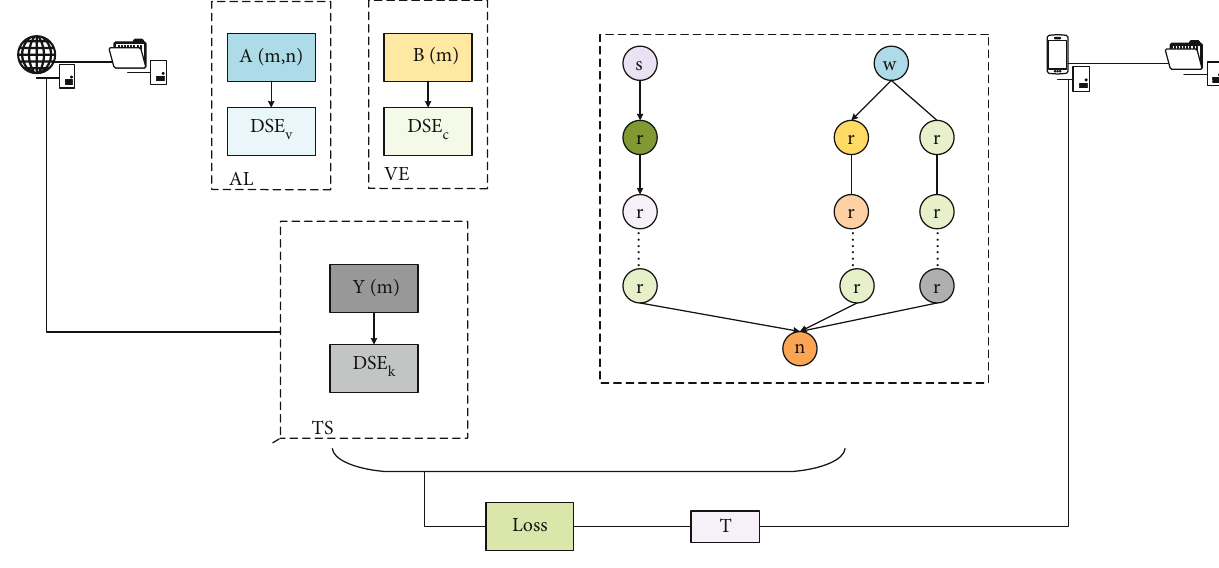
Figure 1: PINN model